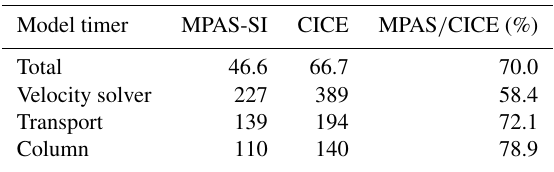
Table 1. Model throughput (in SYPD) for various code sections for MPAS-Seaice and CICE. Results from 32 processors on Anvil with MPAS-Seaice using the “region” partitioning method and CICE us- ing the “slenderX2” partitioning